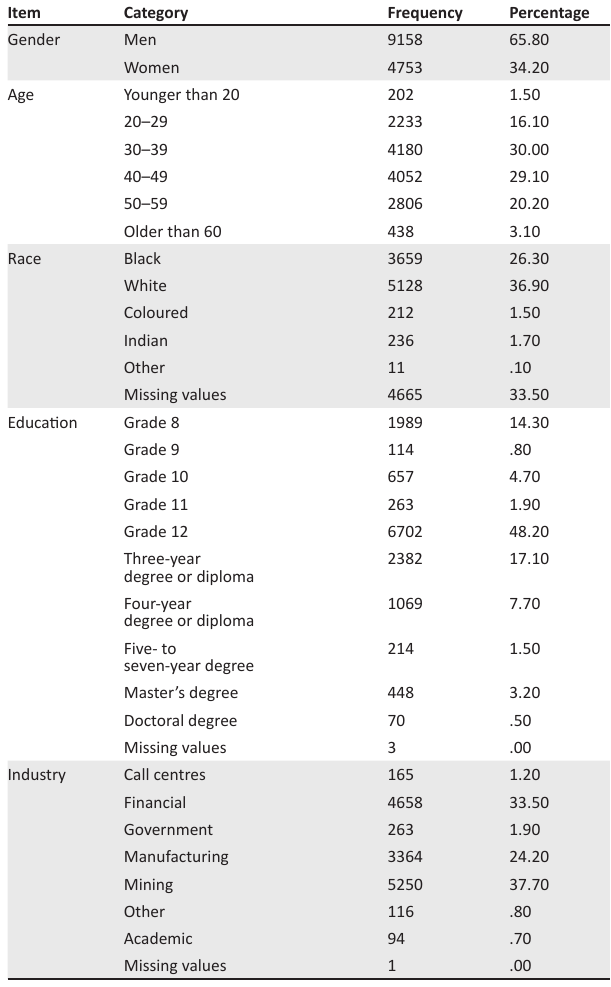
TABLE 1: Characteristics of the